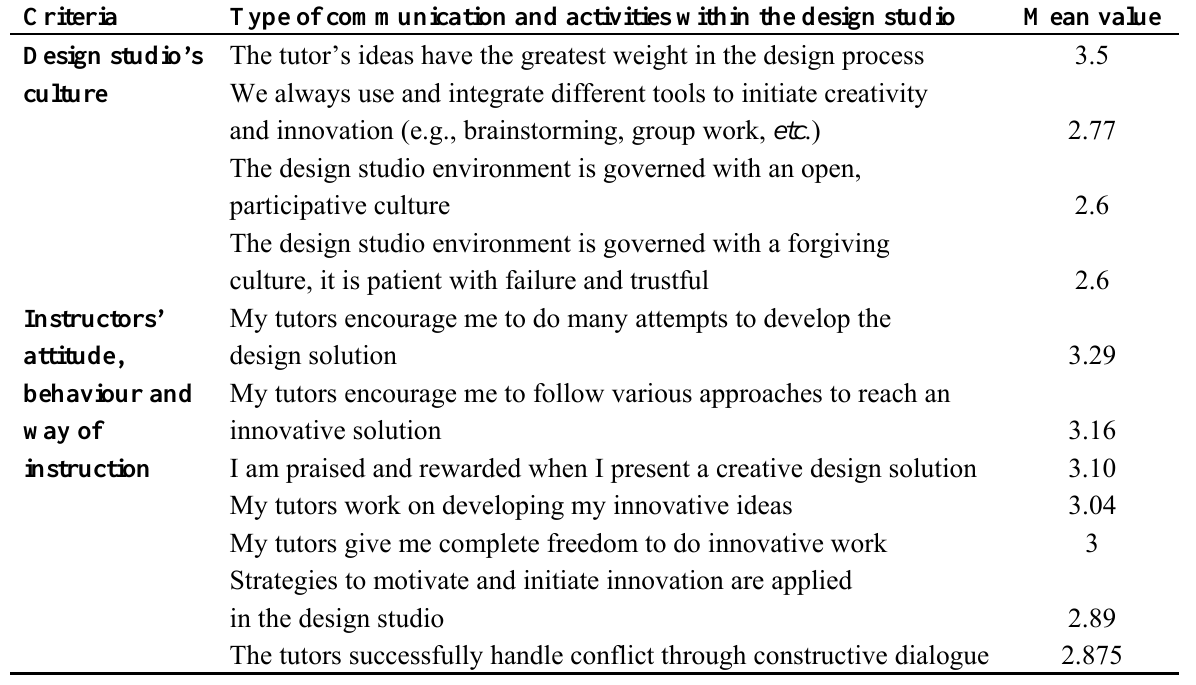
Table 3. The frequency of activities and communications that happen in the design studio during term time (scale: 1: does not happen, 5: always